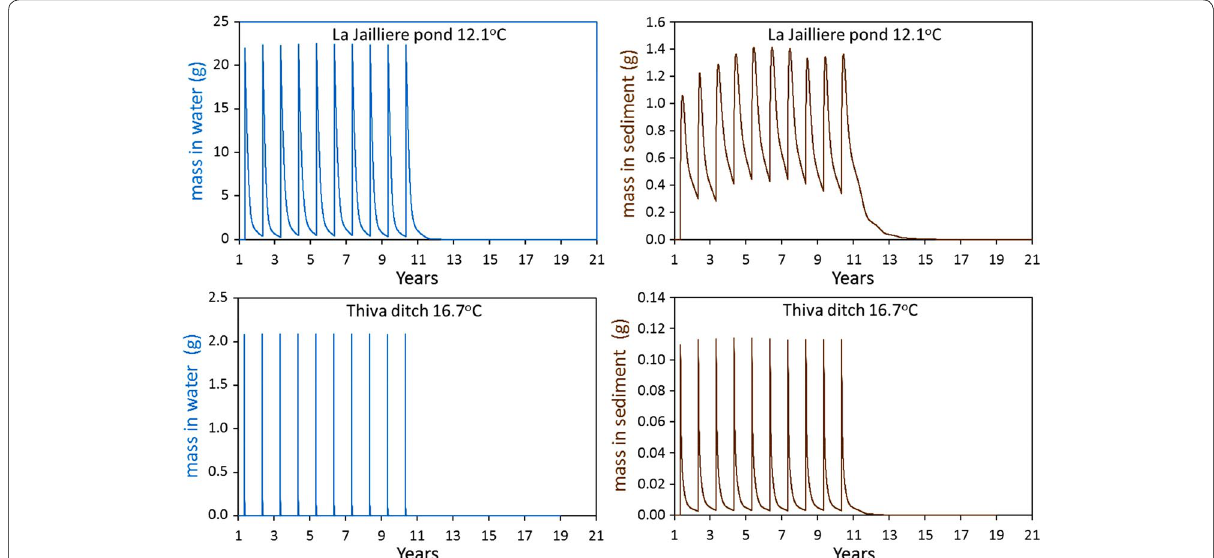
Fig. 2 Mass of a PPP with a half-life of 40 days in water and 120 days in sediment at 20 °C calculated for the FOCUS surface water scenarios La Jail- liere ( top panels ) and Thiva ( bottom panels ) for water ( left panels ) and sediment ( right panels